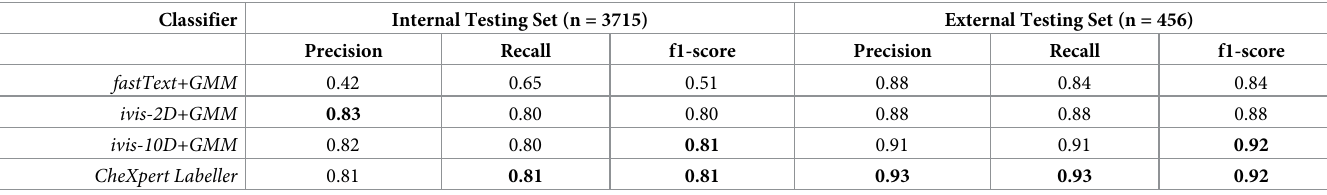
Table 2. Performance comparison of unsupervised classifiers on internal and external radiological reports. Average performance values are reported. Classifier Internal Testing Set (n = 3715) External Testing Set (n = 456) Precision Recall f1-score Precision Recall f1-score fastText+GMM